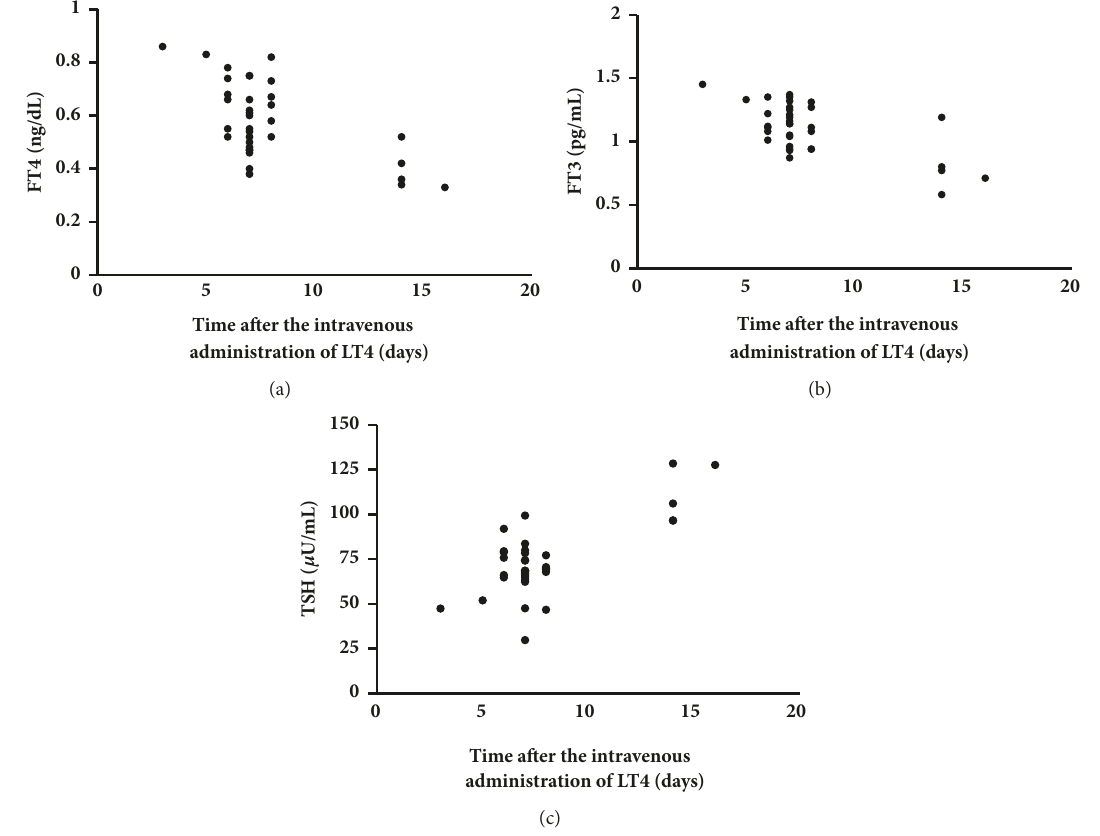
(Table 1). Under oral administration of 200 𝜇 g/day of